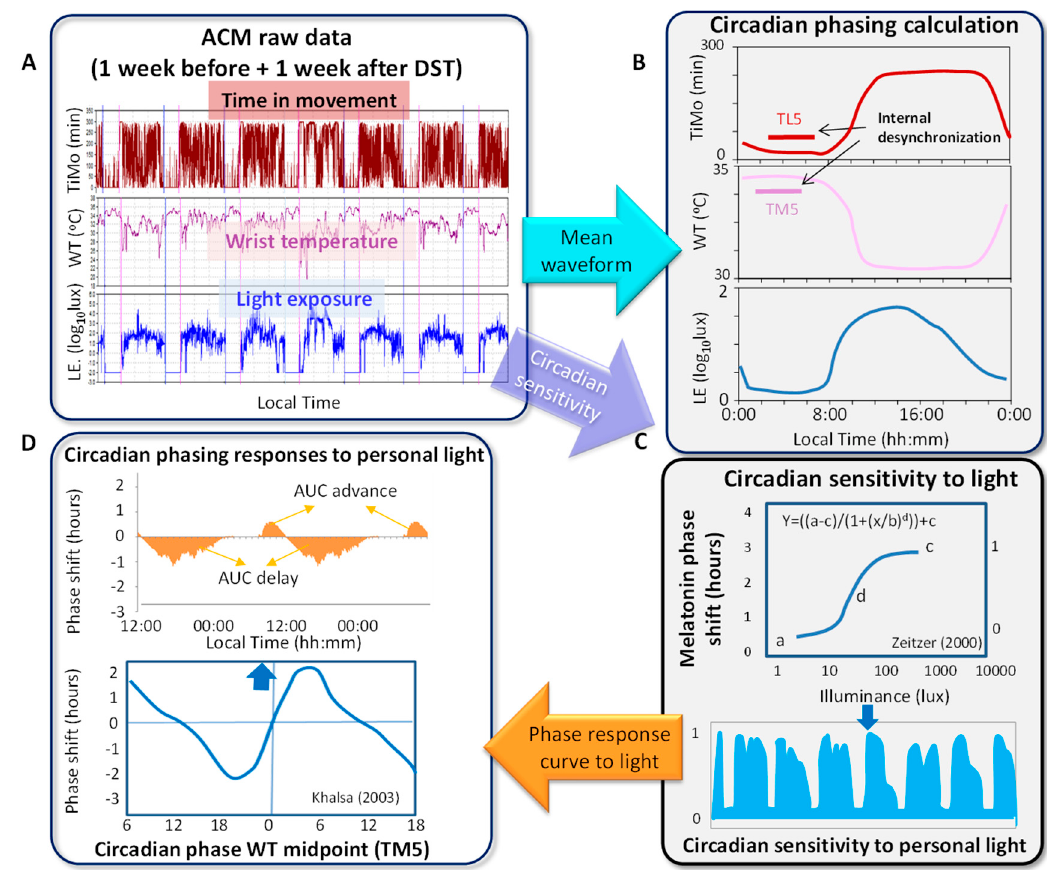
Figure 1. Procedure to analyze light exposure, circadian variables and circadian phasing responses. Once raw data are downloaded from the ACM device ( A ), Kronoware© calculates the daily mean waveforms of wrist temperature (WT), time in movement (TiMo) and exposure to light (LE), as well as their main circadian parameters ( B ). Light exposure is then transformed according to the melatonin phase shift response curve to light intensity ( C ) [58] in order to delimit circadian light sensitivity. The phase response curve to light [51] is then applied to obtain the personalized circadian phasing response to light, which jointly considers both timing and intensity for phase shifting ( D ).